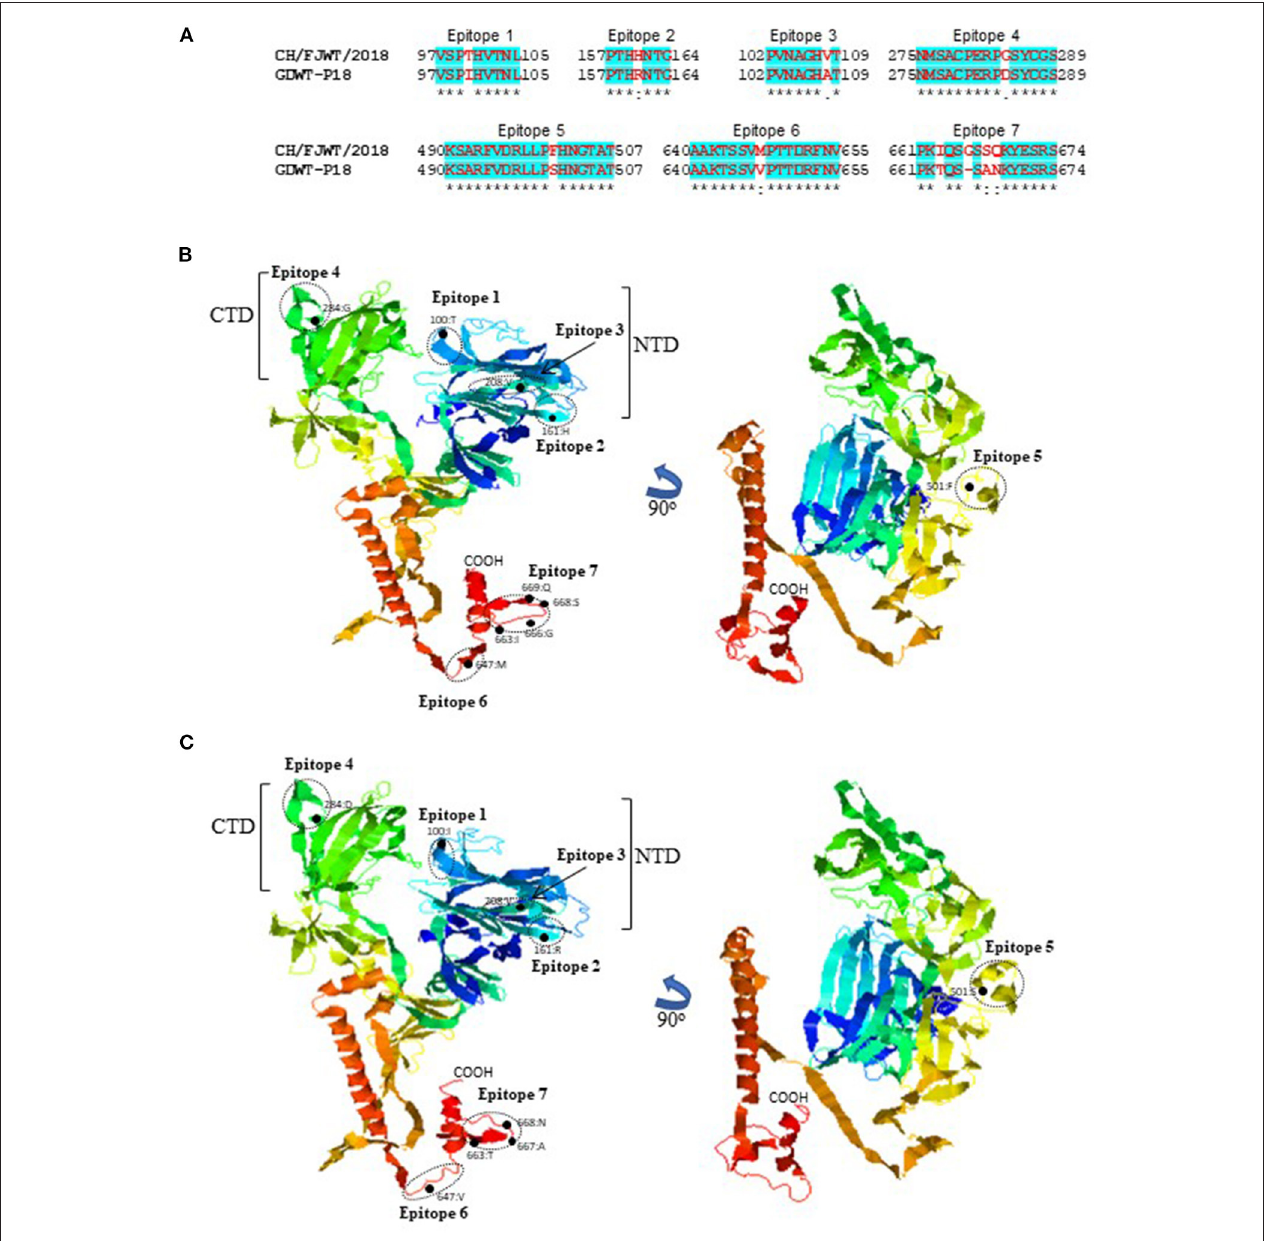
FIGURE 4 | Linear B cell epitopes affected by amino acid variations in the S glycoproteins of SADS-CoVs CH/FJWT/2018 and GDWT-P18. (A) The amino acid sequence of predicted linear B cell epitopes are shown with red bold letters. Numbers indicate the amino acid positions relative to the full-length S glycoprotein of indicated SADS-CoVs. 3D view of epitopes in the S1 subunit and the N-terminus of S2 subunit of CH/FJWT/2018 (B) or GDWT-P18 (C) . 3D structure of S glycoprotein was modeled by using I-TASER server (20–22). The predicted epitopes are circled and the amino acid variations are labeled with black dot. NTD, N-terminal domain (aa 19-254); CTD, C-terminal domain (aa